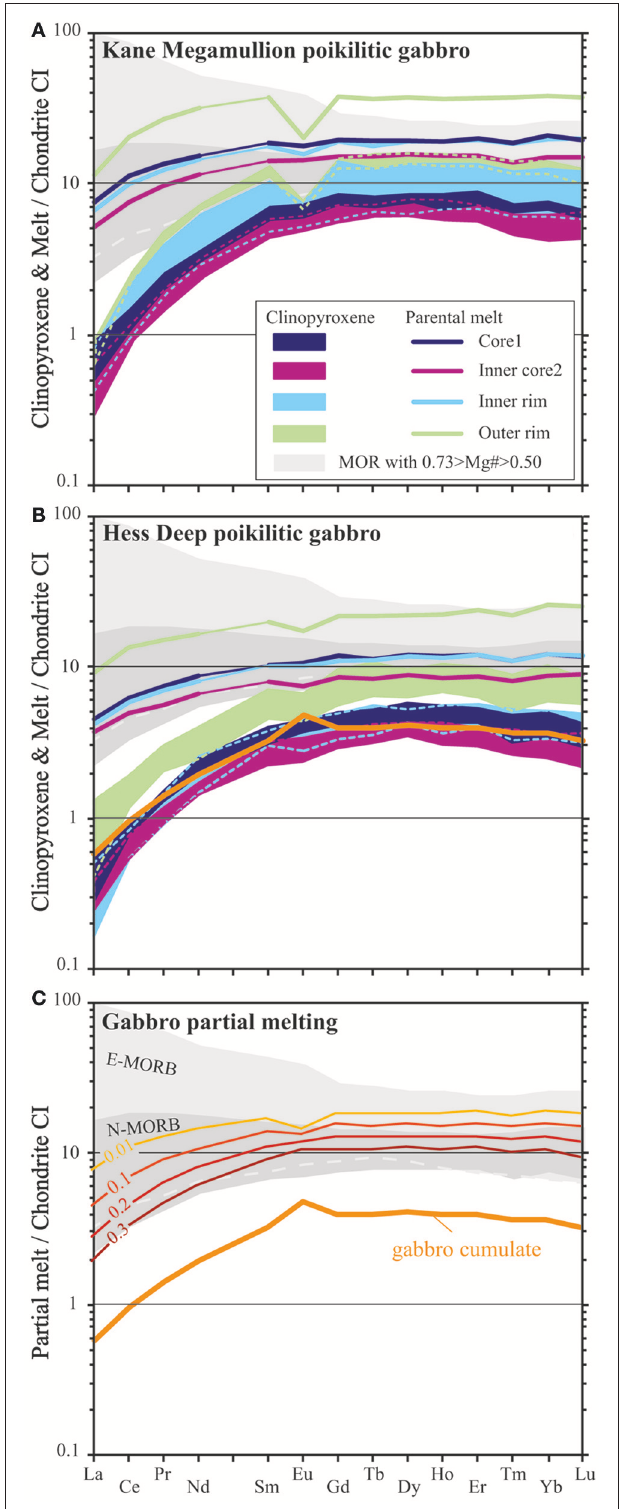
Figure 6 | Chondrite CI- (Boynton, 1984) normalized clinopyroxene core1, inner core2 (only inner part in Hess Deep), rim and outer rim REE compositions